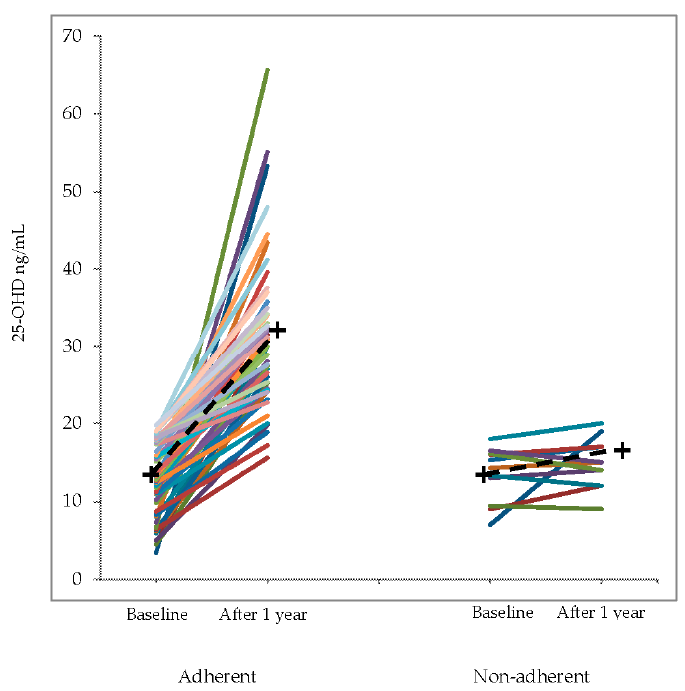
Figure 4. Individual values of 25-OHD before and after vitamin D supplementation in adherent and non-adherent patients. The crosses and the dashed lines represent the mean change.